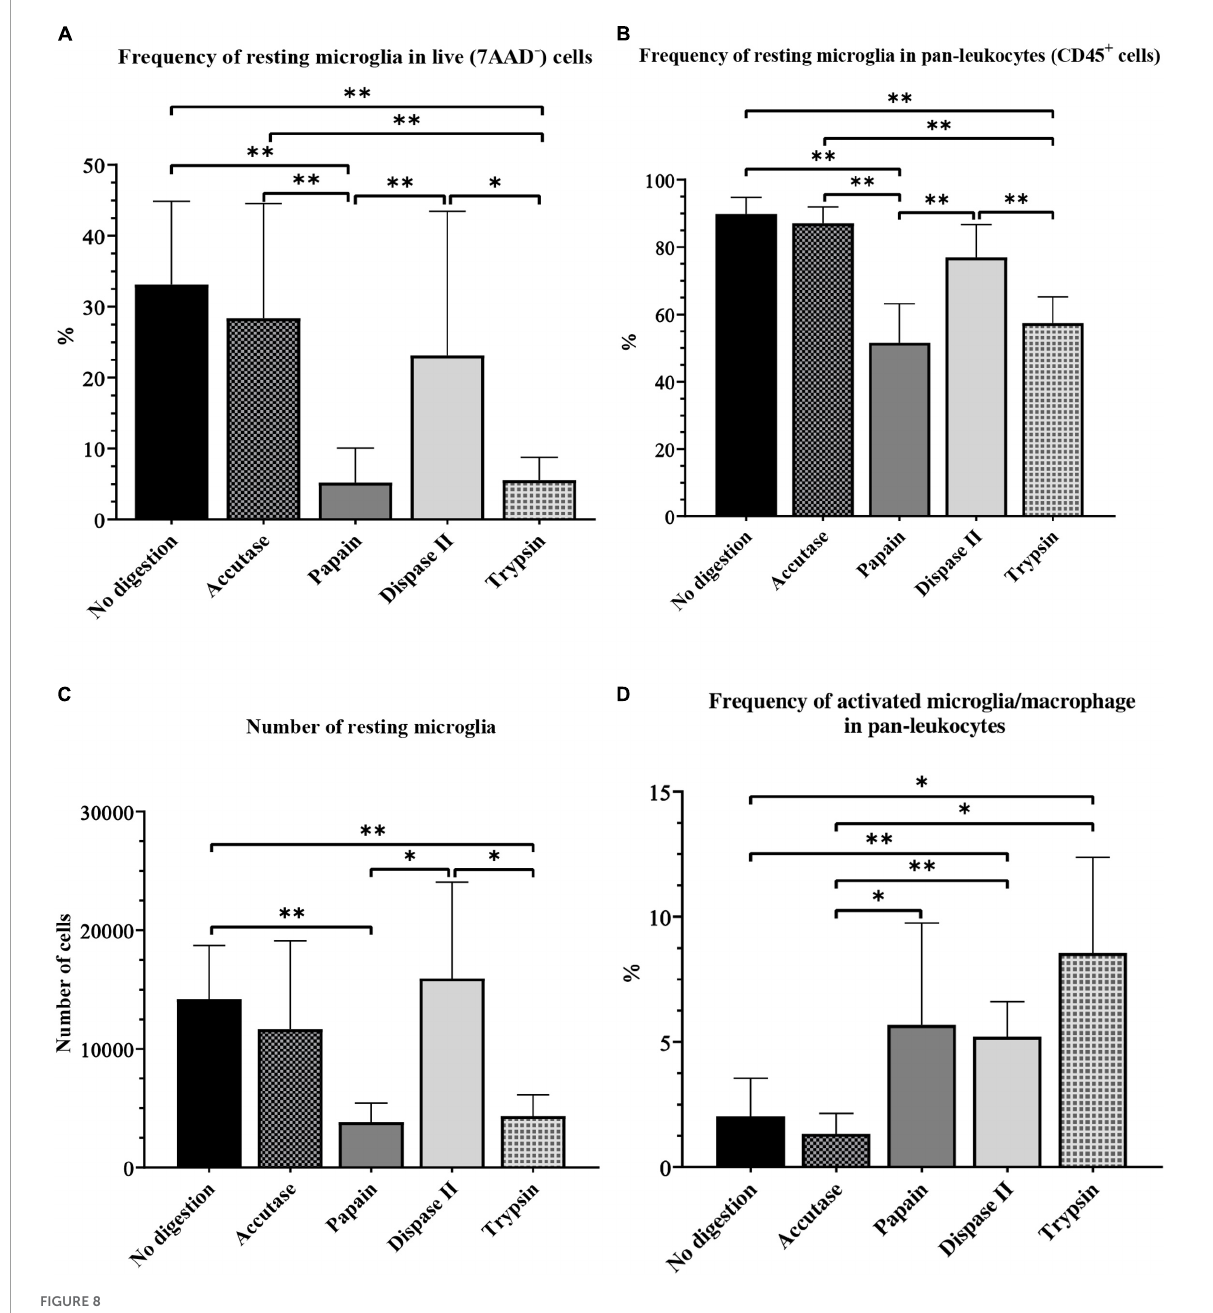
FIGURE8 The effect of different enzymatic brain tissue digestion on microglial yield on flow cytometry: The percentage of microglia in the live-cell population (A) and pan-leukocytes population (B) , absolute number of resting microglia (C) and the percentage of activated microglia and macrophages (D) . ∗ P < 0.05; ∗∗ P < 0.01. N (mice per group) =